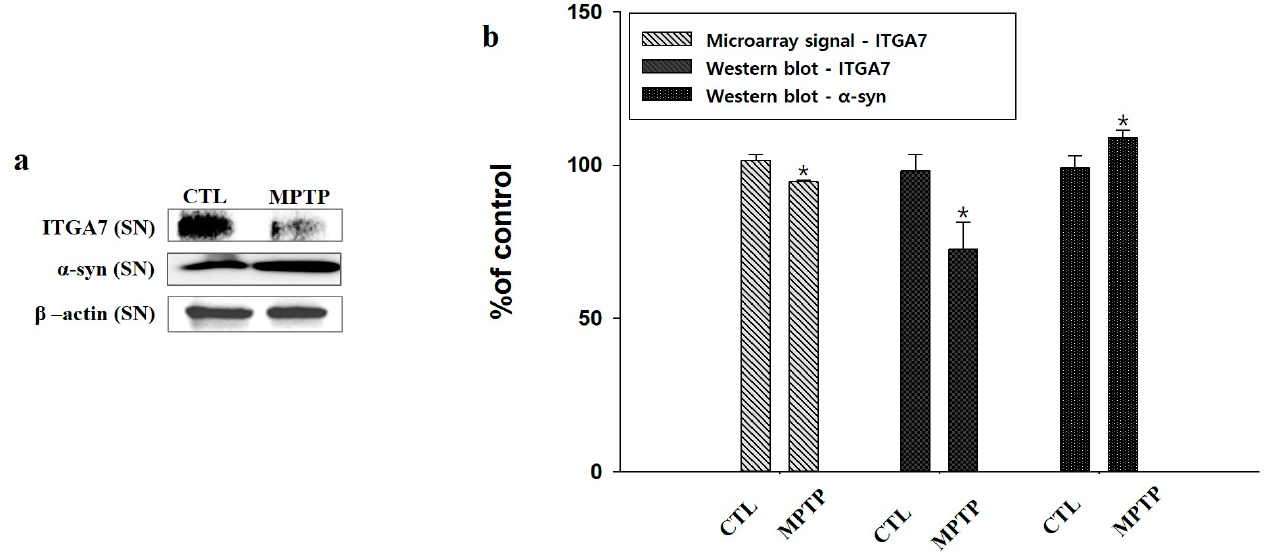
Figure 2. Integrin alpha 7 ( ITGA7 ) expression was decreased and α -synuclein ( α -syn) expression was increased in the MPTP group (MPTP) compared to that in the control group (CTL) in the SN. ( a ) Western blot analysis verified the decreased expression of ITGA7 and the increased expression of α -syn in MPTP-treated mice. ( b ) Histogram shows a significant decrease in ITGA7 expression, detected by Western blot analysis, and the decreased signal of microarray in the MPTP group compared to that in the CTL group. Histogram shows a significant increase in α -syn in the MPTP group compared to that in the CTL group. * denotes p < 0.05 compared to CTL. All values are expressed as mean ± standard error, and statistical analysis was performed using Student’s t -test.